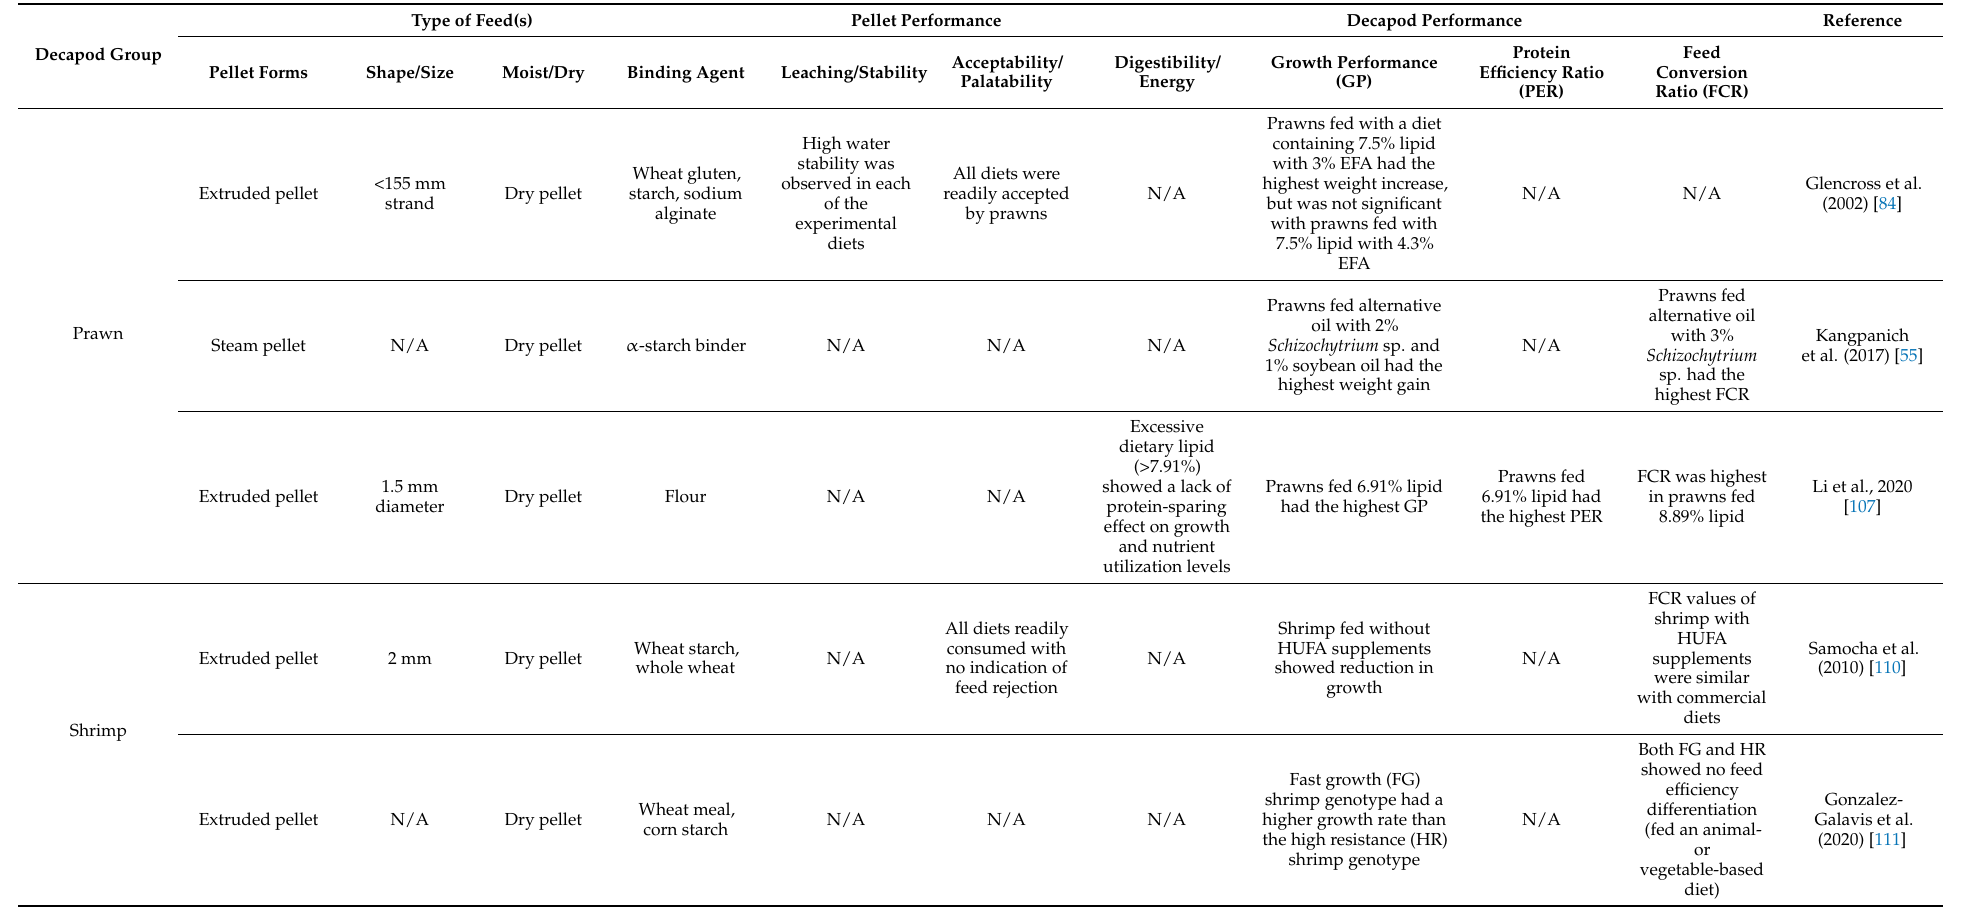
Table 3. Decapod’s pellet forms with pellet and decapod